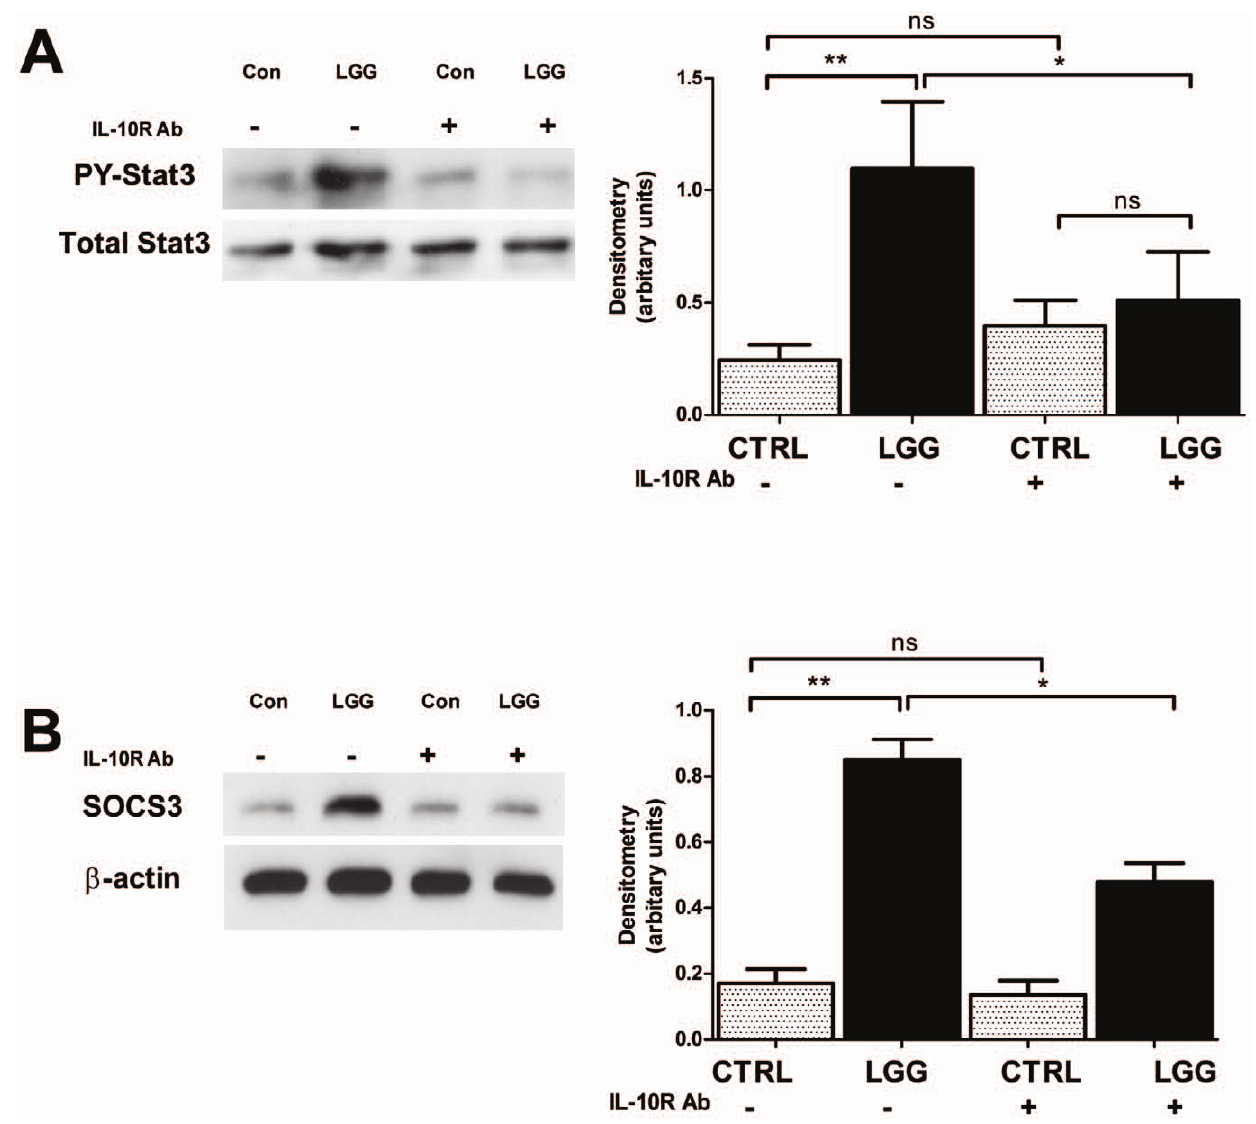
Figure 4. LGG triggers IL-10 receptor-dependent phosphorylation of STAT3 and induces SOCS3 in the colon of 2 week-old mice. 2 week-old mice were treated by intraperitoneal injection with either 200 m g IL-10R Ab or an isotype-matched control immediately prior to gavage feeding with 10 8 CFUs LGG or vehicle alone. 6 hours after treatment, the mice were sacrificed and the colon was processed for western blot analysis of phospho- and total STAT3 (A). Similar analysis was performed for SOCS3 at 24 hours after treatment (B). Densitometric analysis was performed and the mean ratio 6 SEM of detected phosphorylated STAT3 to total STAT3 was plotted for each condition (A). (n=3 separate experiments, 5 mice per condition, *p , 0.05, **p ,